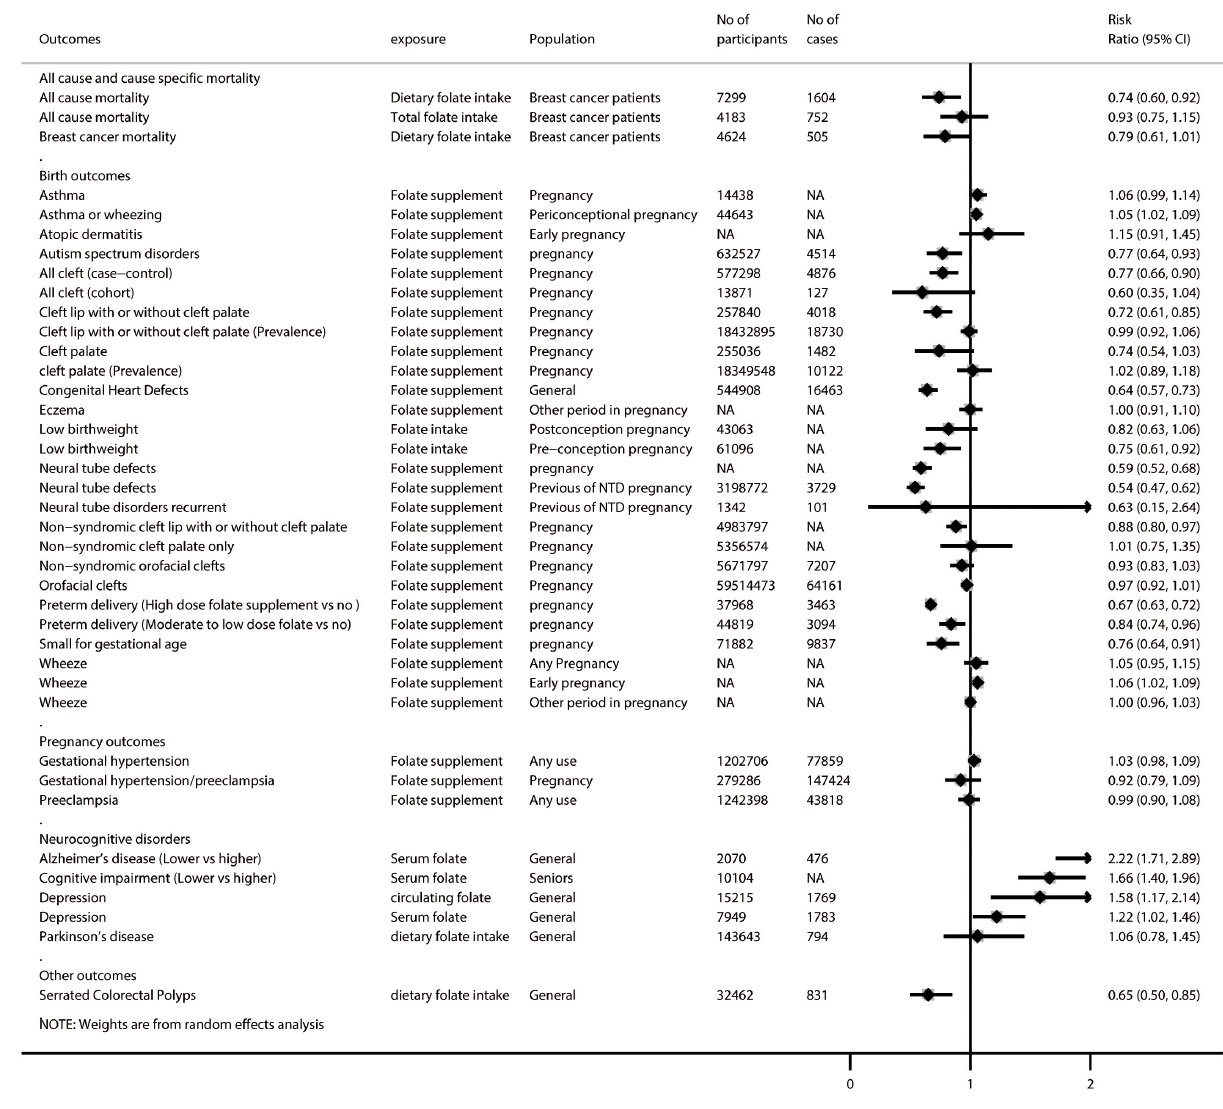
birth outcomes ( n = 17), cancer-related outcomes ( n = 14), cardiovascular outcomes ( n = 29), diabetes-related outcomes ( n = 9), endothelial function ( n = 5), neurocognitive disorders (